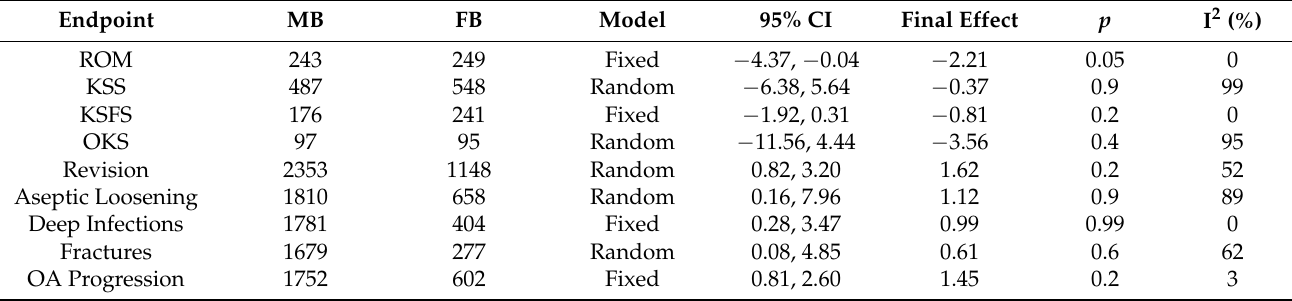
Table 2. Main results of the meta-analyses. The final effect was evaluated as odds ratio for bi- nary data and as mean difference for continuous data (MB: mobile bearing; FB: fixed bearing; CI: confidence